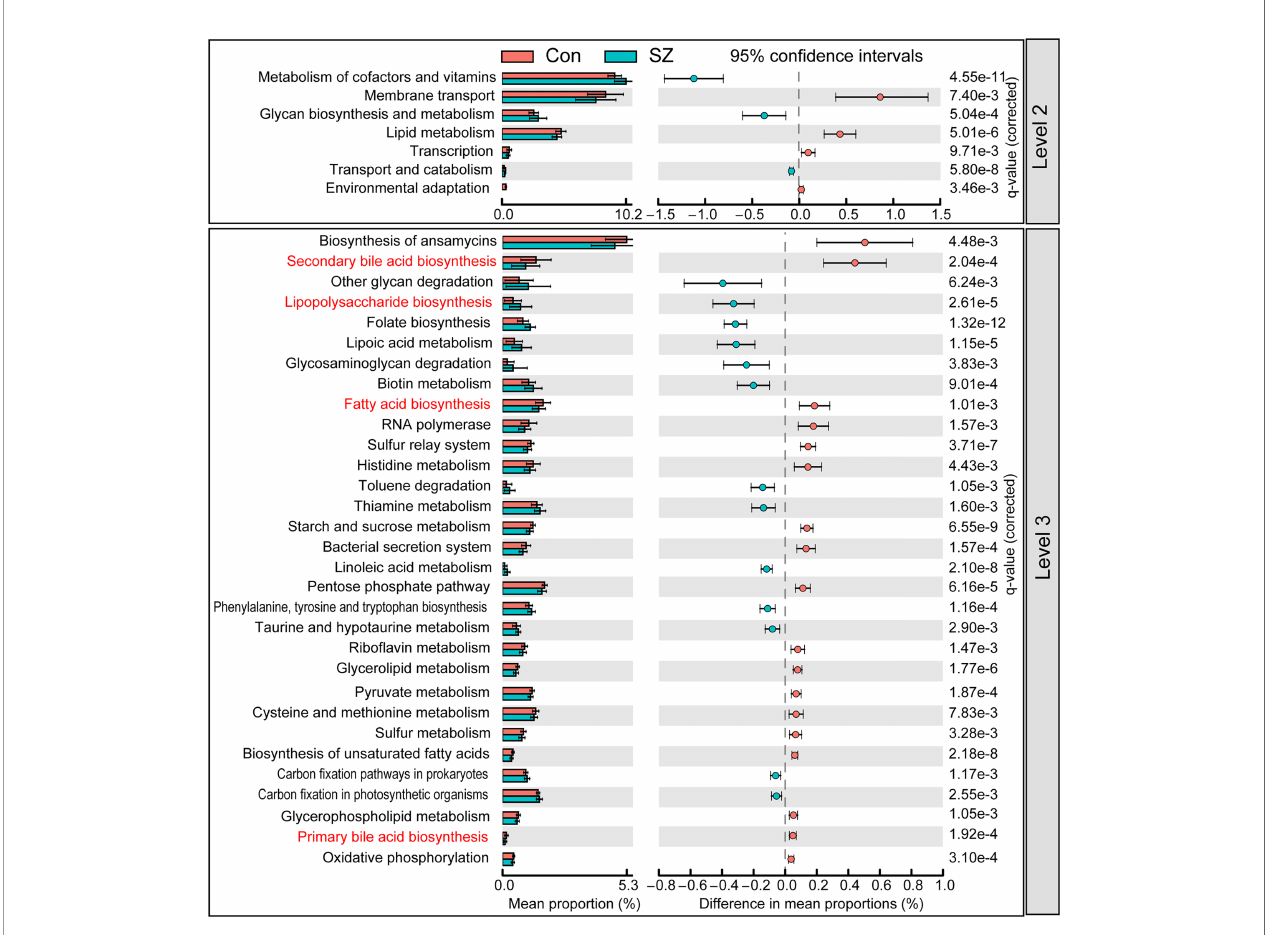
FIGURE 5 | PiCRUSt-based examination of the fecal microbiome of the elderly SZ patients and the healthy controls. The different bacterial functions were evaluated between them based on two-sided Welch ’ s t -test. Comparisons between the groups for each KEGG functional category (levels 2 and 3) are shown by percentage. The Benjamini – Hochberg method was used for multiple testing correction based on the false discovery rate (FDR) through